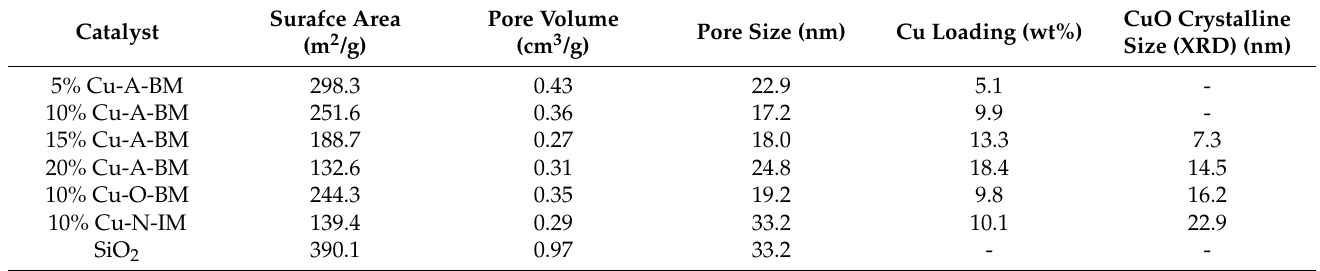
Table 1. The textural properties and ICP results of W%Cu-A-BM, 10%Cu-O-BM, 10%Cu-N-IM.